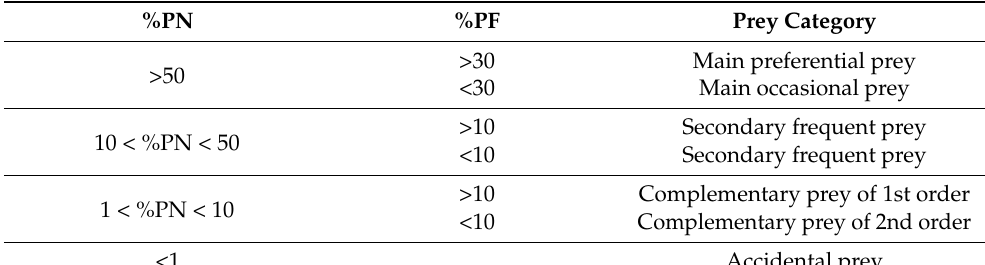
Table 2. Prey categories according to Hureau [57] (%PF = frequency of occurrence, %PN = numerical index). %PN %PF Prey Category >30 Main preferential prey >50 <30 Main occasional prey >10 Secondary frequent prey 10 < %PN < 50 <10 Secondary frequent prey >10 Complementary prey of 1st order 1 < %PN < 10 <10 Complementary prey of 2nd order <1 Accidental